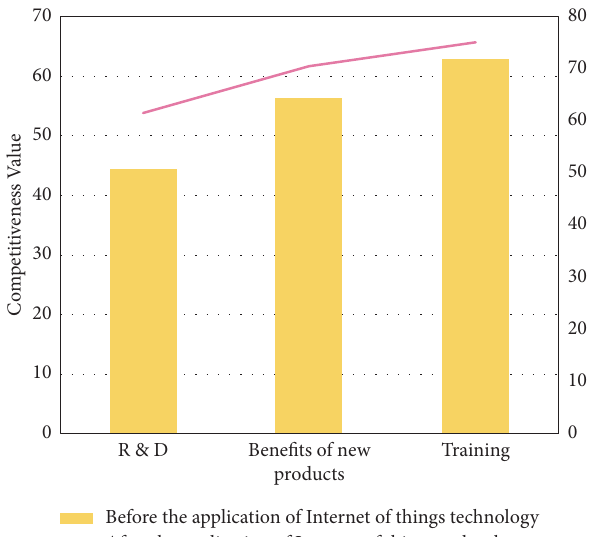
Figure 11: Comparison results before and after the competitive- ness value of each subindex of learning and innovation